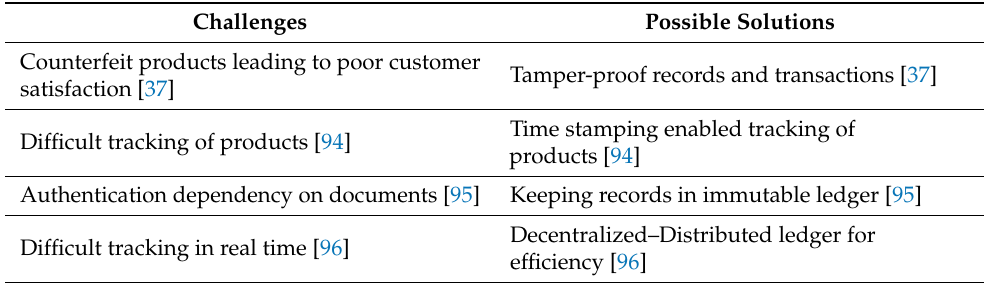
Table 1. Blockchain for Supply